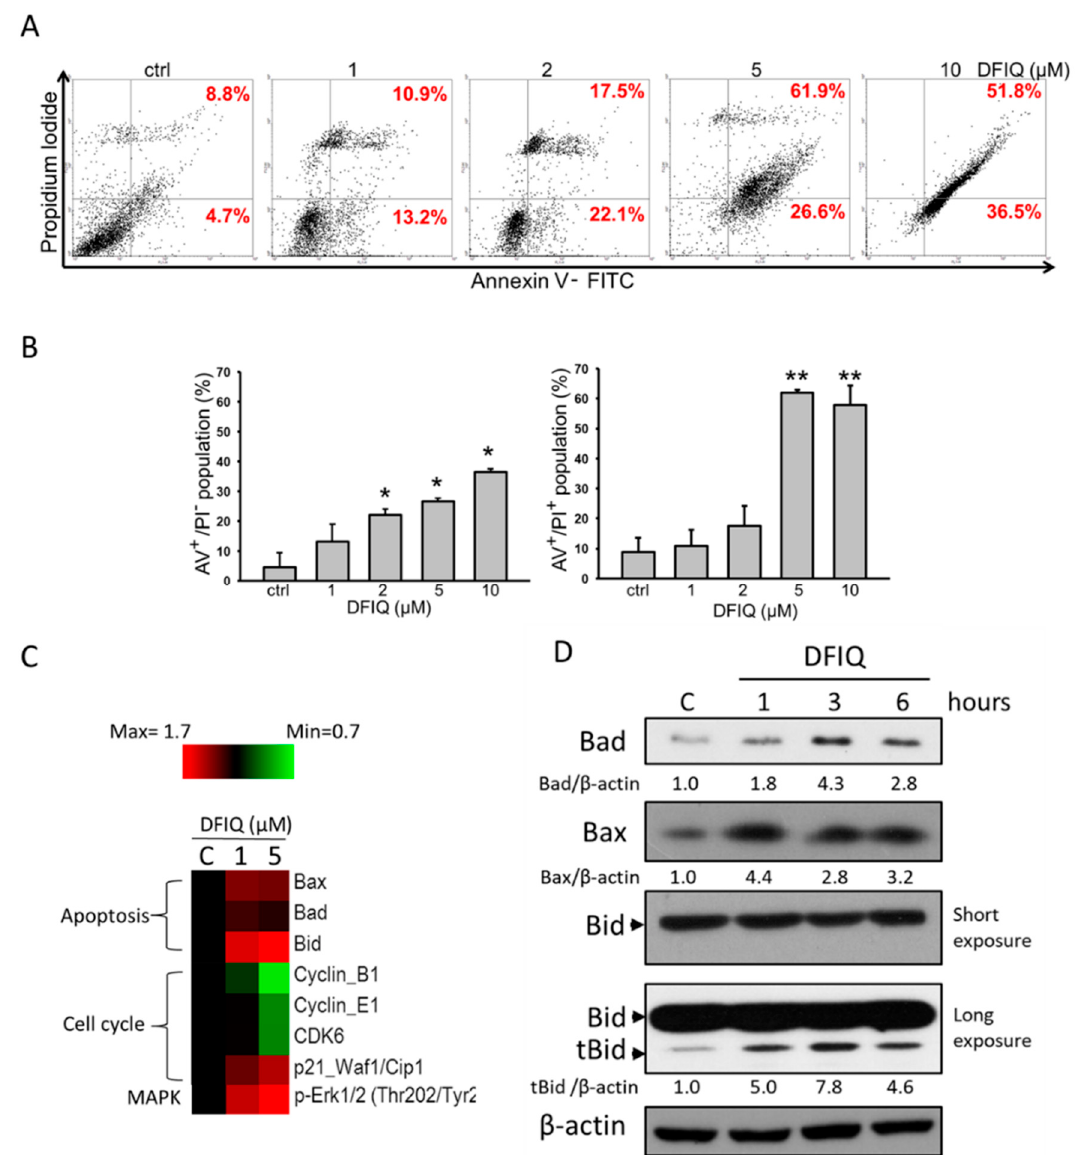
Figure 2. DFIQ treatment induced apoptosis of lung cancer cells. ( A ) H1299 cells were treated with control or 1, 2, 5, or 10 µ M DFIQ for 24 h and subjected to Annexin V / PI staining to analyze the apoptotic cells. ( B ) Quantification of early apoptotic cells (fourth quadrant) and late apoptotic cells (first quadrant) in ( A ). ( C ) Micro-Western array analysis of the expression changes in apoptotic and cell cycle proteins after DFIQ treatment in H1299 cells. ( D ) Western blot analysis demonstrating the expression of the apoptotic proteins Bad, Bax, and tBid after DFIQ treatment. β -Actin was measured as a loading control. ** p < 0.01, * p < 0.05 compared with the control group. The uncropped blots and molecular weight markers of Figure 2D are shown in Figure S6.